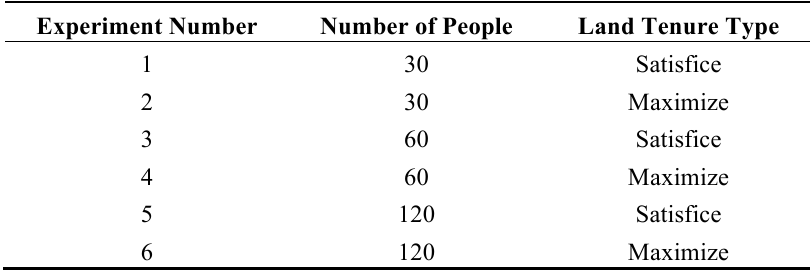
Table 1. Table of modeling experiments